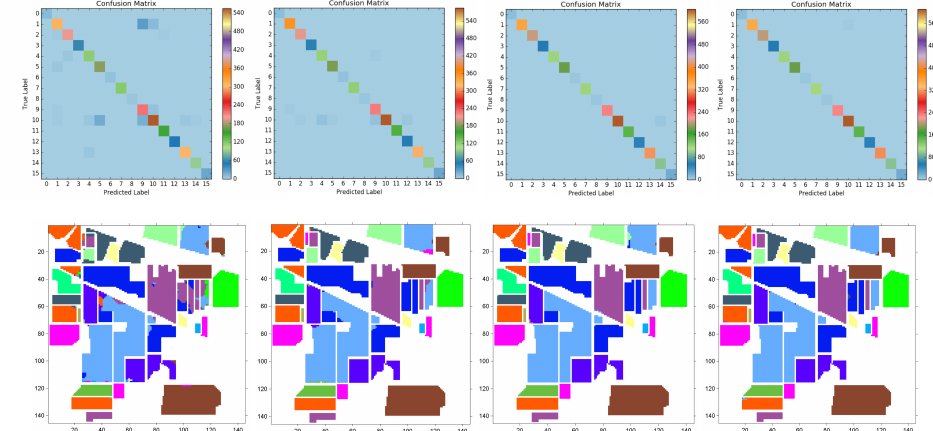
Figure 14. Classification results for the IP image with d = 29 and number of samples per category = 50 (first column), 100 (second column), 150 (third column), and 200 (fourth column). The upper row represents the visualization results of the confusion matrix for each category on the testing set (the more prominent the color of the diagonal area, the better the result) and the lower row represents